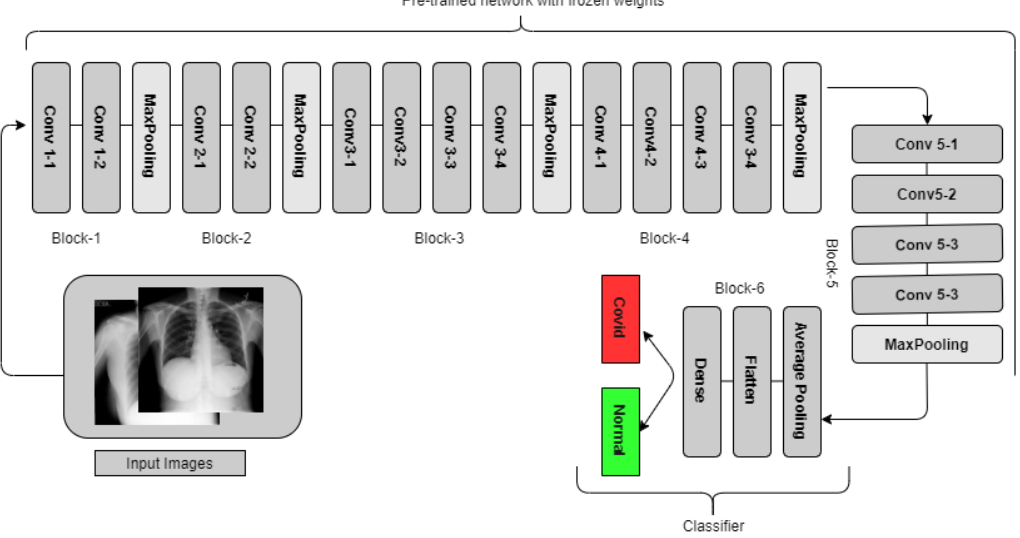
Figure 4. VGG19 in our classification experiments. For the four class problems, Normal, COVID, Lung Opacity, and non-COVID viral pneumonia were detected, whereas for two classes, only COVID and normal images were detected.